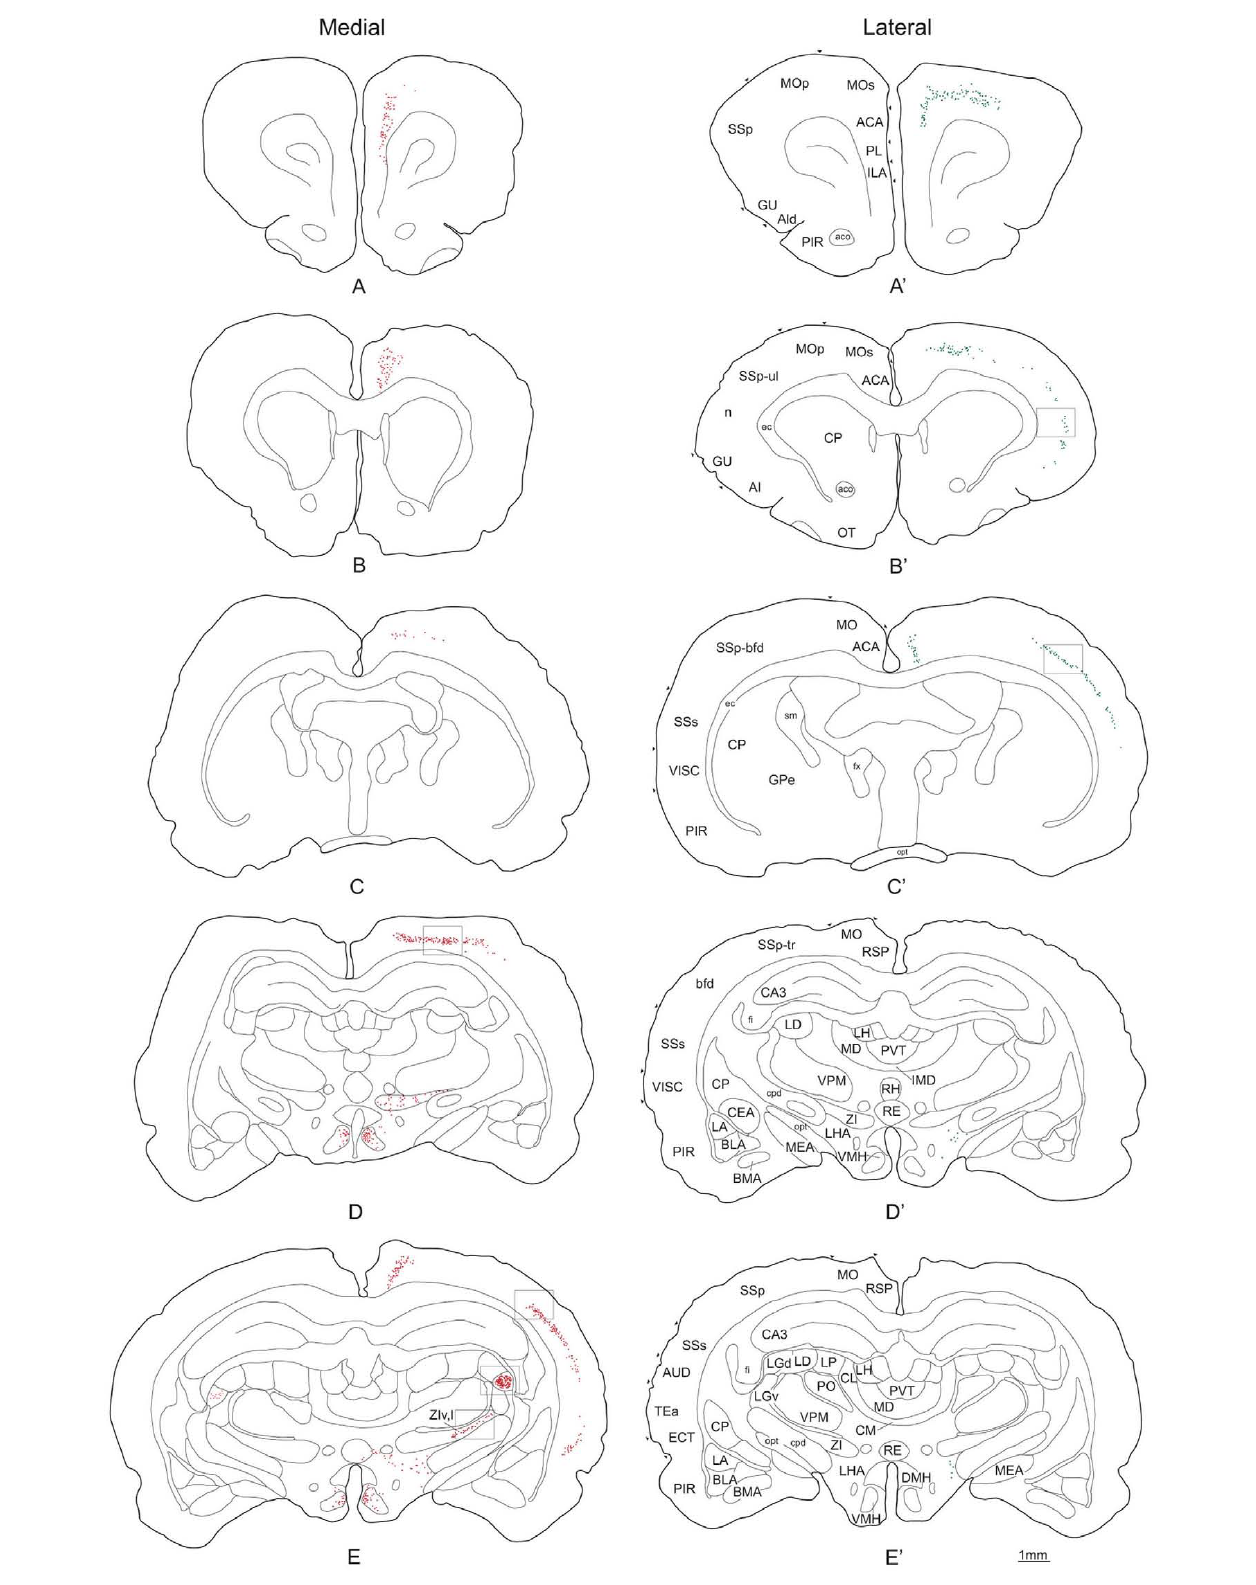
FIGURE 5 | Distribution of retrogradely labeled cells after a FG injection into SCm (left side-red dots) and SCl (right side-green dots). Open squares indicate which levels the pictures in Figures 6 – 8 were taken from. A photomicrograph of the injection sites is illustrated in Figure 4 . Abbreviations: see list.